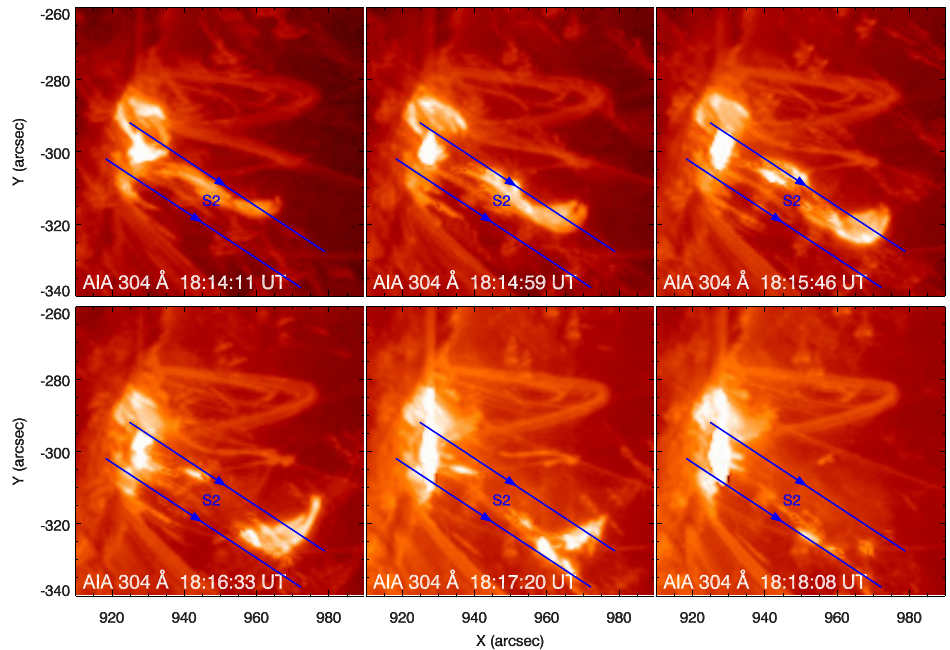
Figure 6. The time evolution of jets between 18:14:11 UT and 18:18:08